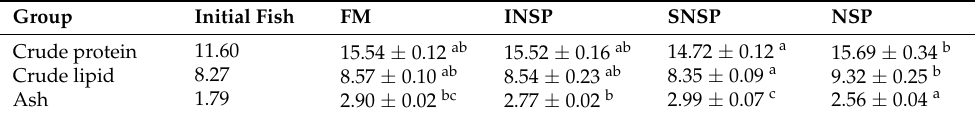
Table 6. Whole body composiiton of grass carp fed by test feeds (dry matter).